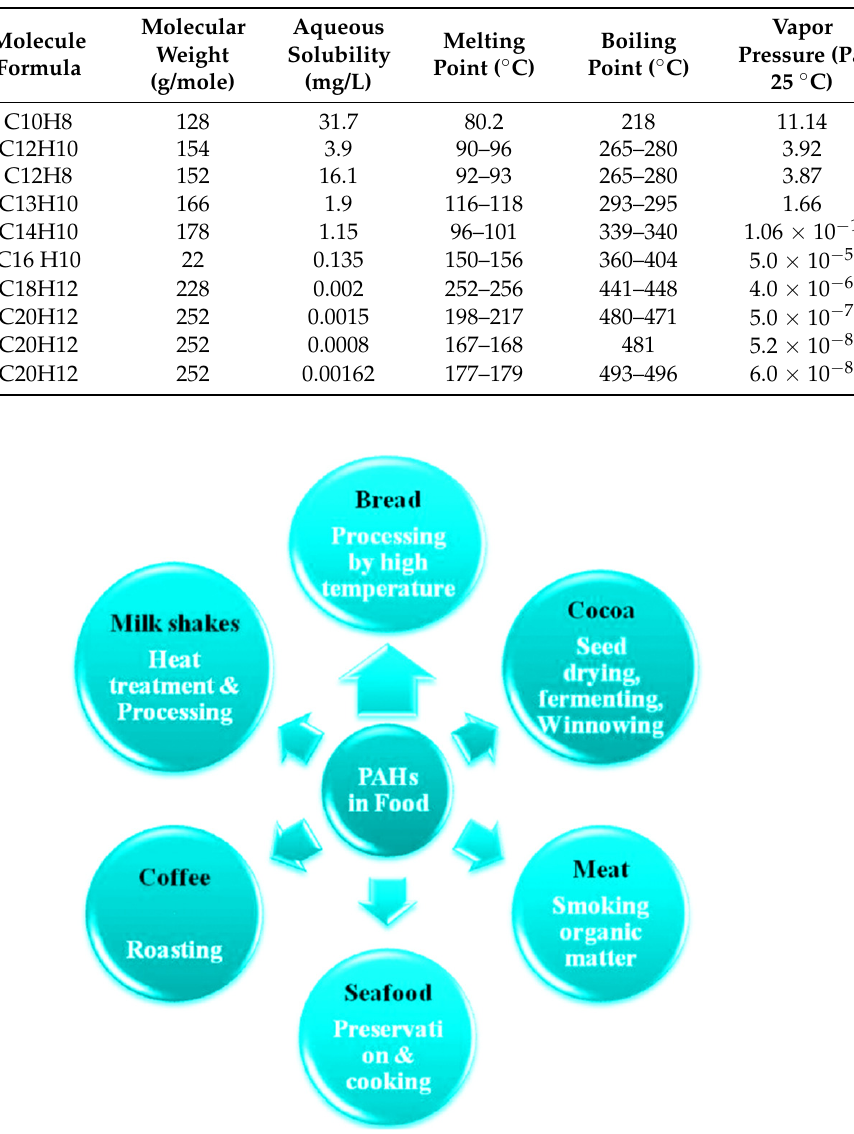
Table 1. Characteristics of physical–chemical priority compounds of PAH contaminants [29,30].